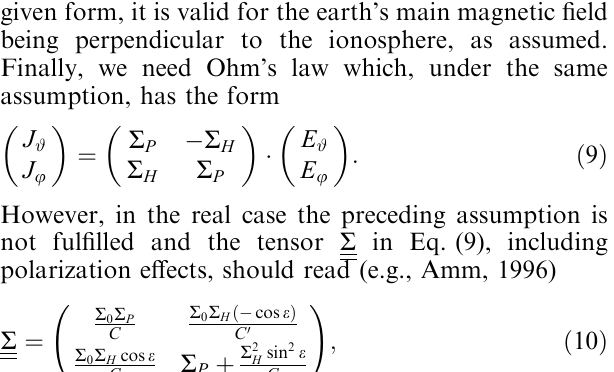
Fig. 2. Components of conductance tensor (cid:82) e(cid:128)ects, for a dipole main magnetic field; in relative units, with (cid:82) H (cid:17) 2 and (cid:82) P (cid:17) 1 (see horizontal dotted lines